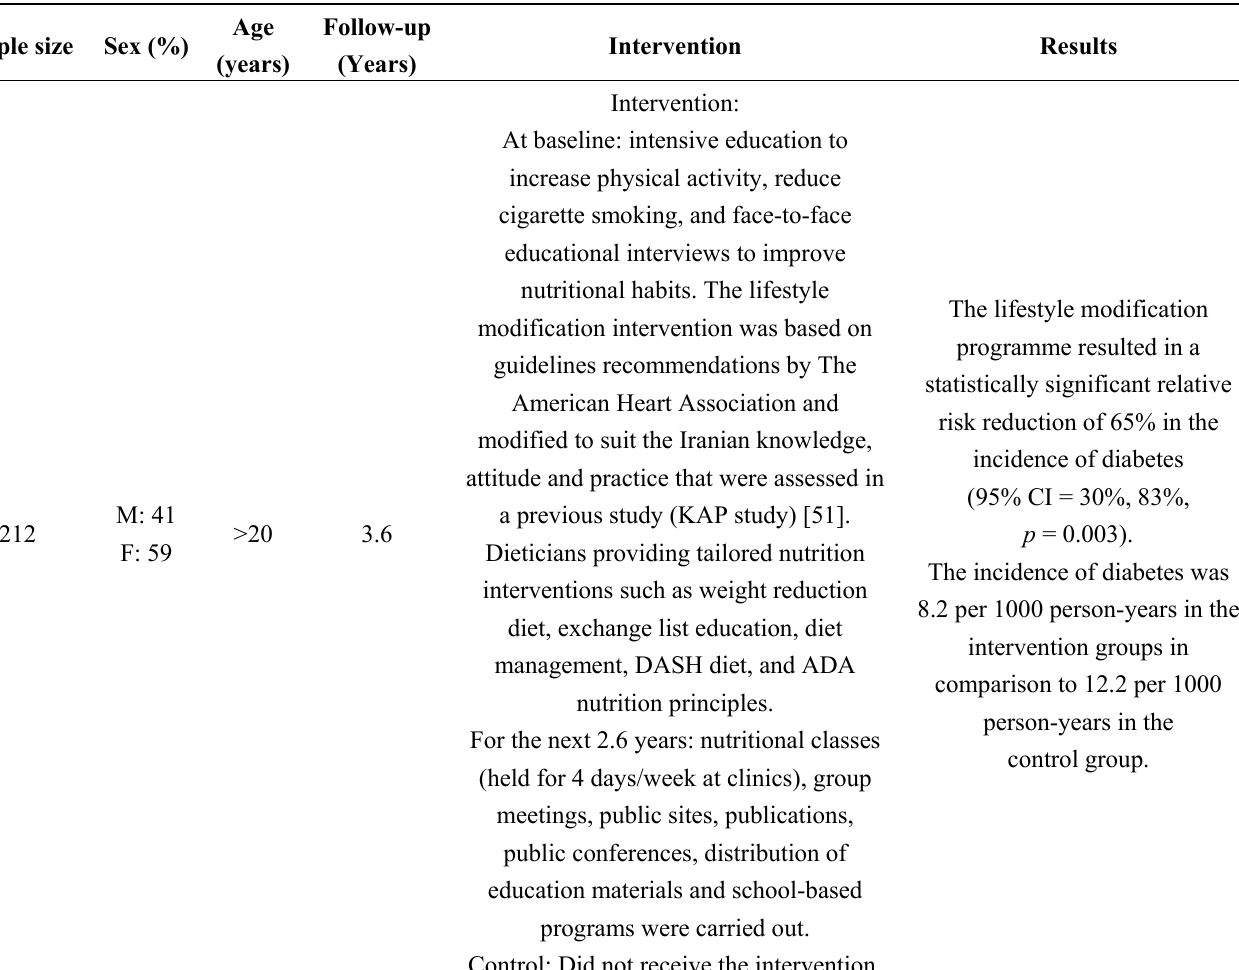
Tables 3. Association between lifestyle factors and T2DM in intervention